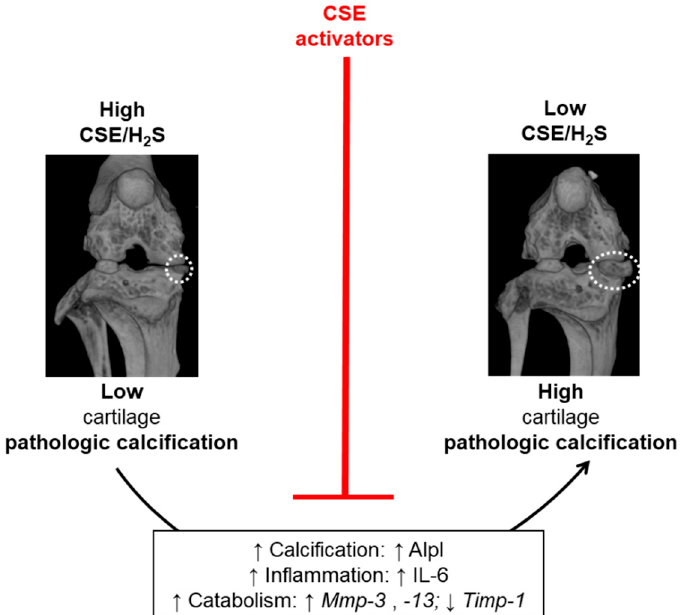
Figure 5. Proposed mechanism for CSE involvement in cartilage PC. High CSE expression, therefore high levels of H 2 S, in knee cartilage are associated with low pathologic calcification. Conversely, low CSE expression, and decreased H 2 S levels, favor pathologic calcification in cartilage. In particular, we described that lack of CSE sustains chondrocyte calcification in vitro and in knee in vivo, partly via increased Alp expression and/or activity. In addition, low CSE expression is associated with increased IL-6, which is known to amplify calcification, as previously described [4]. Finally, low CSE combines with increased Mmp-3 and Mmp-13 expression and decreased Timp-1 expression in vitro, leading to tissue degeneration. Restoring physiological levels of H 2 S in cartilage by CSE activators can block cell calcification and IL-6 production, and may therefore be of therapeutic relevance for the treatment of pathologic calcification in osteoarthritis.